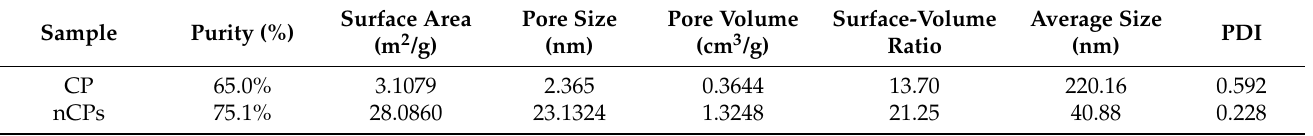
Table 3. Physicochemical properties of CaO 2 and